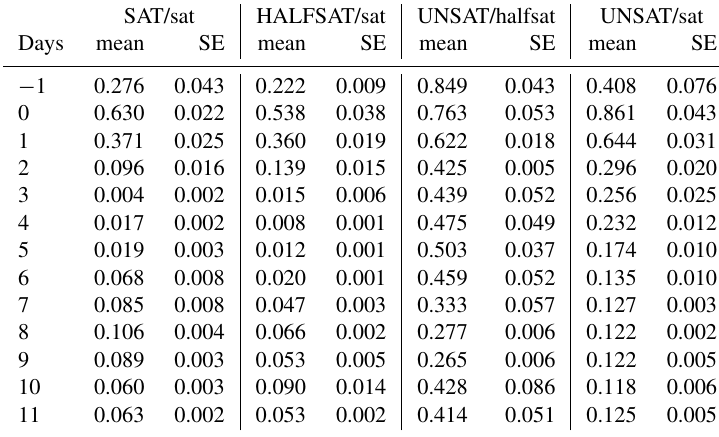
Table 5. Ratios N 2 O / (N 2 O + N 2 ) for all